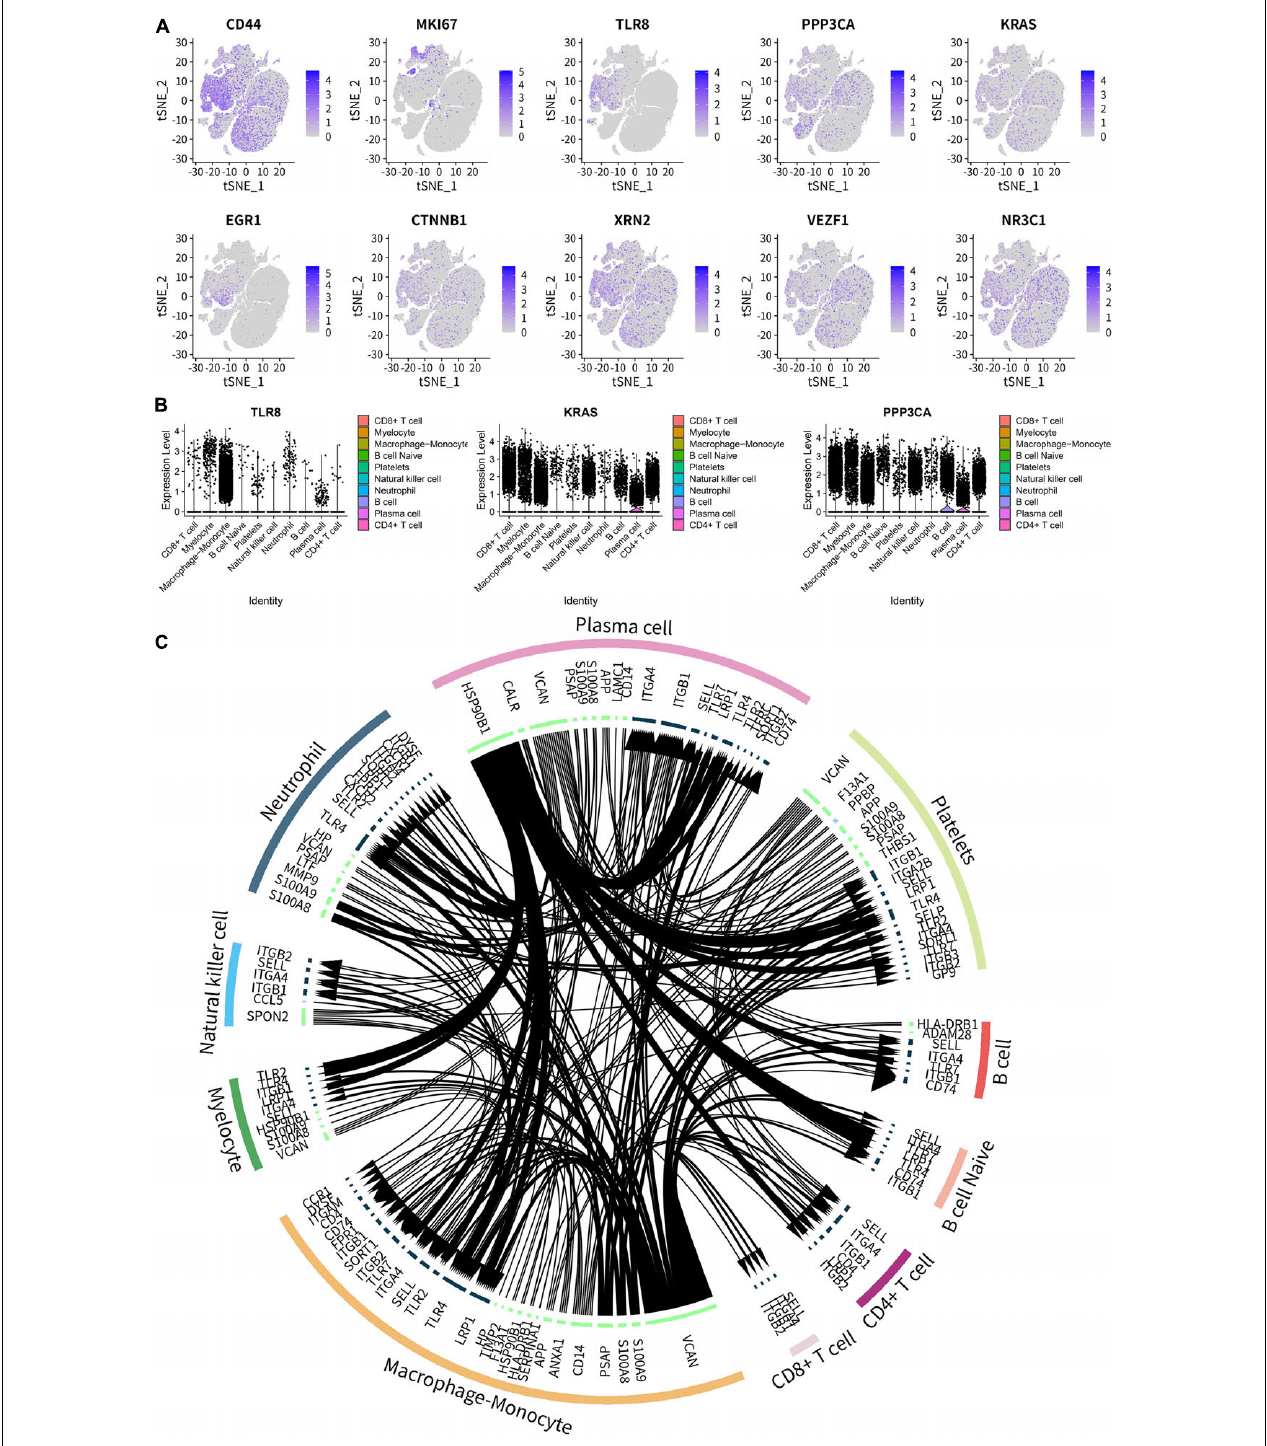
FIGURE 11 | Cell type annotation and cellular communication analysis. (A) Cellular feature plots showing expression levels and specific cellular locations of the key SSIRGs (CD44, MKI67, TLR8, PPP3CA, and KRAS) and TFs (EGR1, CTNNB1, XRN2, VEZF1, and NR3C1) in different immune cells. (B) Violin plot showing the expression levels of three key SSSIRGs (TLR8, KRAS, and PPP3CA) in 10 immune cell clusters. TLR8 was significantly highly expressed in Macrophage–Monocyte, Myelocyte, and Neutrophil; KRAS was significantly highly expressed in Myelocyte, CD8+ T cell, and Macrophage–Monocyte; PPP3CA was significantly highly expressed in CD8+ T cell, Myelocyte, and Macrophage–Monocyte. (C) Intersected cellular communication ligand-receptor plots showing the specific mechanism of intercellular signal transduction.